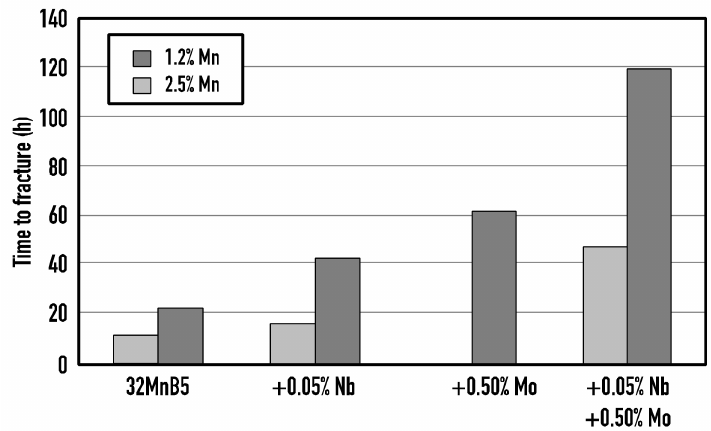
Figure 18. Effect of metallurgical optimization strategies on the delayed fracture resistance of a 2000 MPa tensile strength steel (32MnB5) using Mo and Nb alloying (double-notched tensile sample immersed in 20% ammonium thiocyanate solution under constant load conditions with an acting stress of 1000 MPa at the